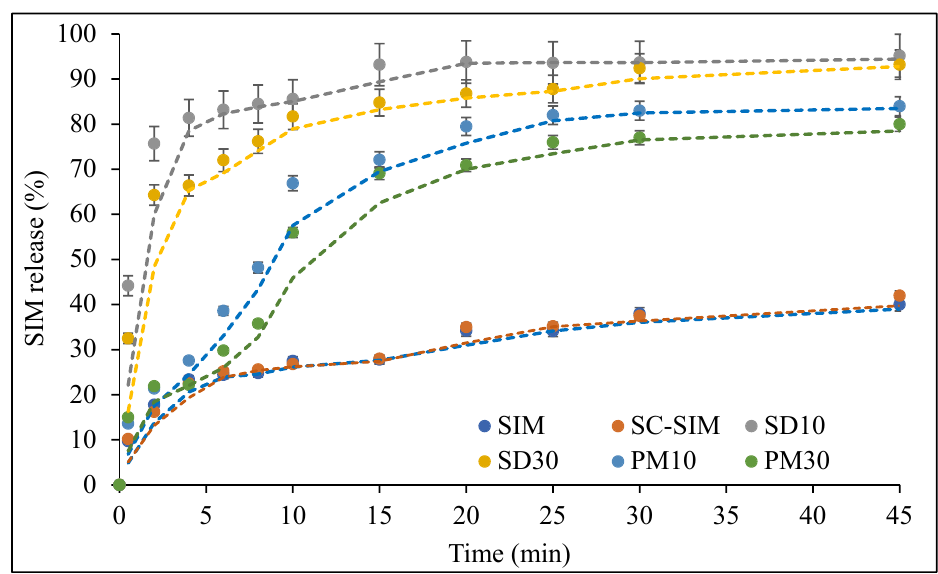
◦ C in pH 7 phosphate buffer containing